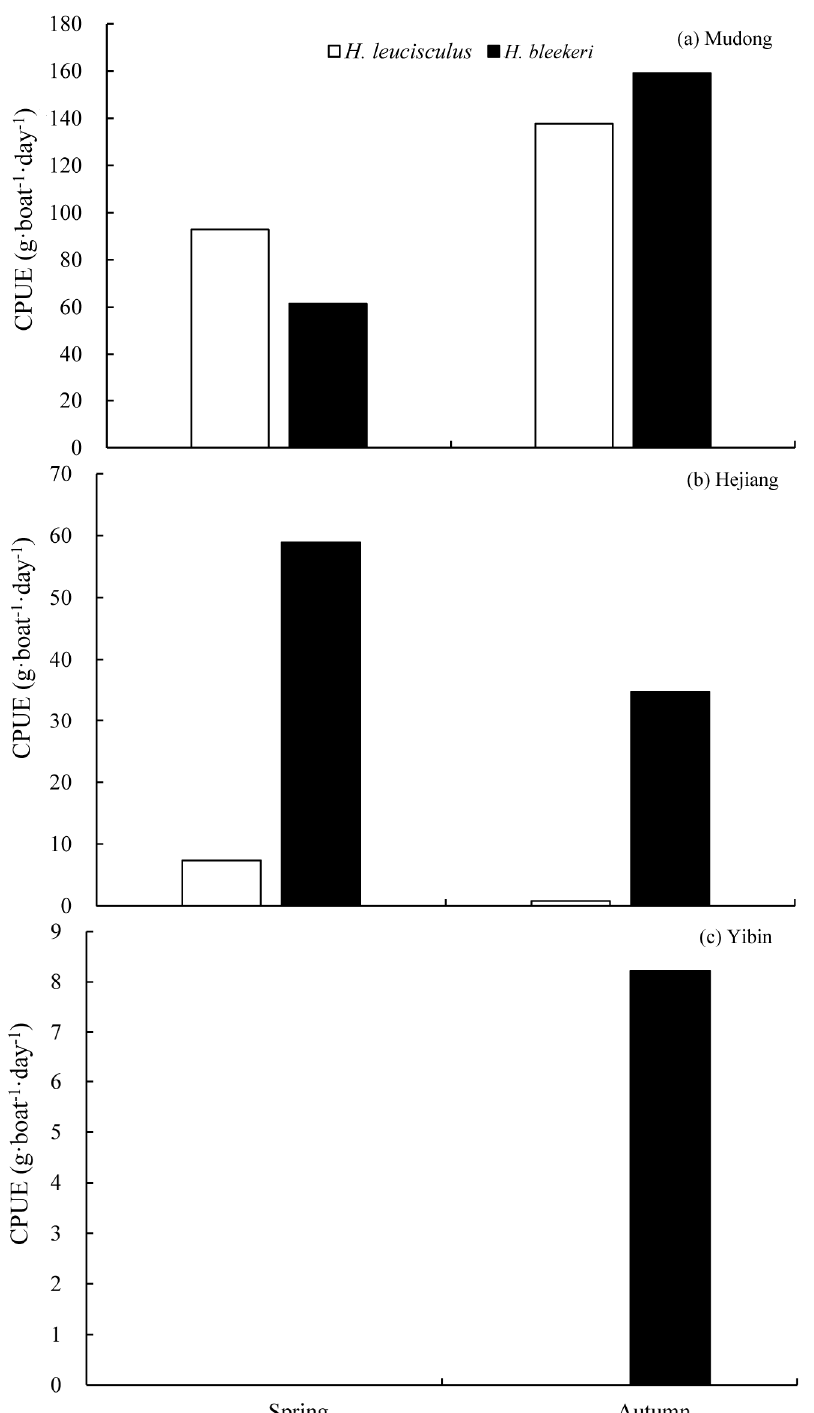
Figure 5. CPUE of H. leucisculus and H. bleekeri in the Mudong, Hejiang, and Yibin reaches in spring (May–June) and autumn (September–October), 2012–2016 (( a ): Mudong, ( b ): Hejiang, ( c ): Yibin). The blank square represents H. leucisculus and the solid square represents H.